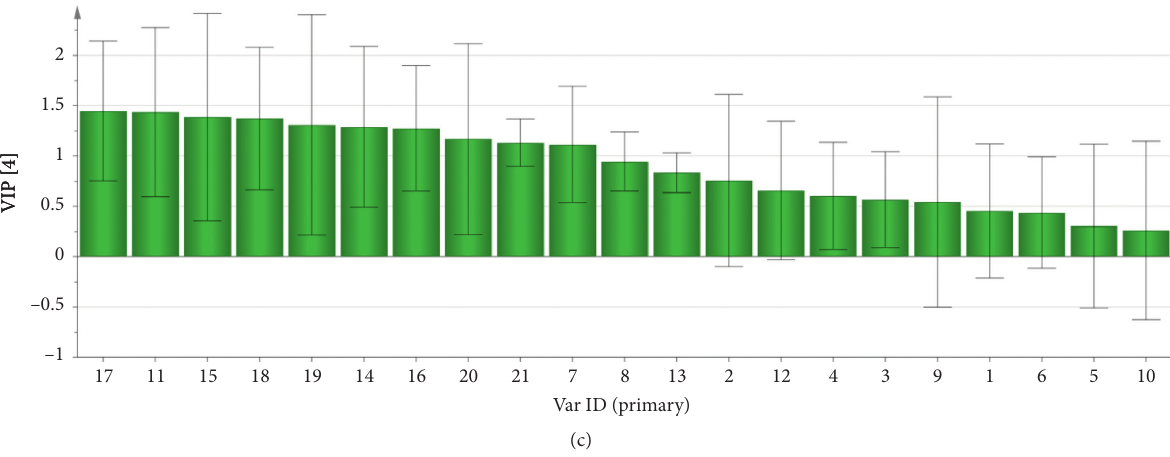
Figure 3: The results of statistical analysis by OPLS-DA: (a) score scatter plot; (b) permutation; (c) VIP plot.